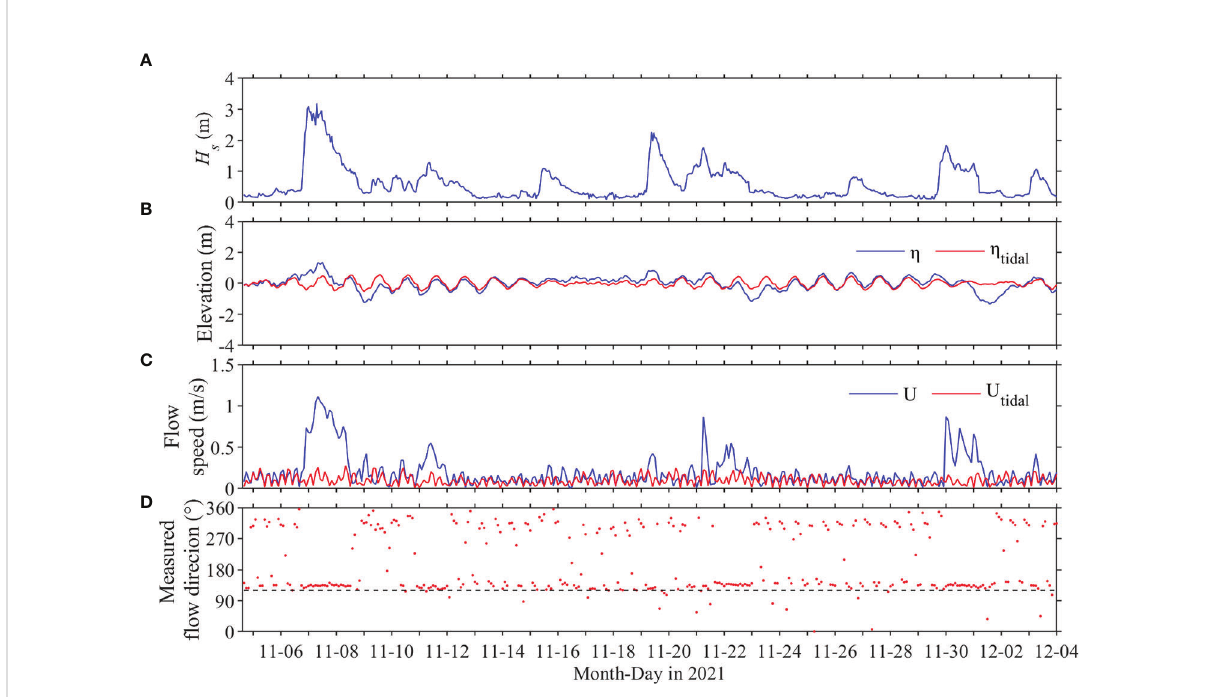
FIGURE 6 Time series of (A) signi fi cant wave height Hs , (B) variation in water level measured (blue line), tidal-induced water level from T_tide package (red line), (C) fl ow velocity, and (D) fl ow direction measured. The black dashed line represents the average orientation of the Gudong seawall. The elevation datum of the water level is de fi ned as the average water depth (6.7 m) during the observation